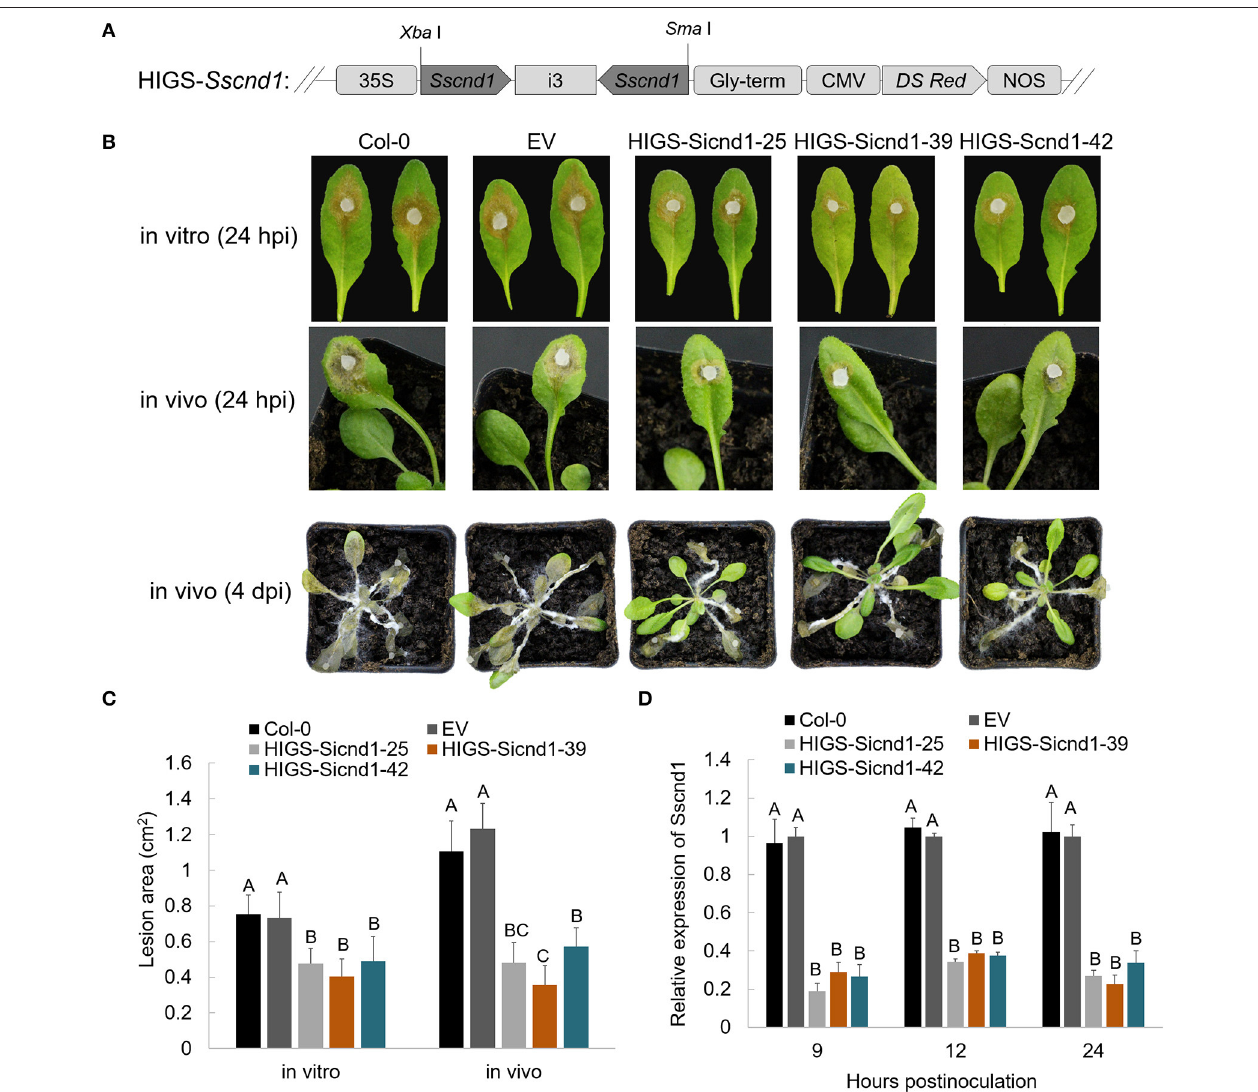
FIGURE 7 | Expression of the HIGS- Sscnd1 construct in Arabidopsis thaliana enhances resistance to S. sclerotiorum . (A) Diagram representing the construct of the HIGS- Sscnd1 vector. (B) Disease phenotypes of the leaves of Col-0 (wild-type A. thaliana ), EV ( A. thaliana lines containing the empty vector) and HIGS- Sscnd1 transgenic A. thaliana lines (HIGS-Sicnd1-25, HIGS-Sicnd1-39, and HIGS-Sicnd1-42) in vitro (at 24 hpi) and in vivo (at 24 hpi and at 4 dpi) after inoculation with S. sclerotiorum wild-type strain 1980. One representative biological replicate is shown. (C) Quantification of the lesion area in (A) at 24 hpi in vitro and in vivo . Error bars indicate the standard deviation for five replicates. Differences in the in vitro group and in vivo group were assessed using Tukey’s HSD test, respectively. Different letters indicate statistical significance at the 0.05 level ( P < 0.05). (D) Relative transcript levels of Sscnd1 in the leaves at 9, 12, and 24 hpi with the S. sclerotiorum wild-type strain 1980. The quantity of Sstub1 was used to normalize the expression levels of Sscnd1 in different samples. Error bars indicate the standard deviation of three independent assays. At every time point, the relative abundance of Sscnd1 in EV was set as one. Differences in every time point group were assessed using Tukey’s HSD test, respectively. Different letters indicate statistical significance at the 0.05 level ( P < 0.05).